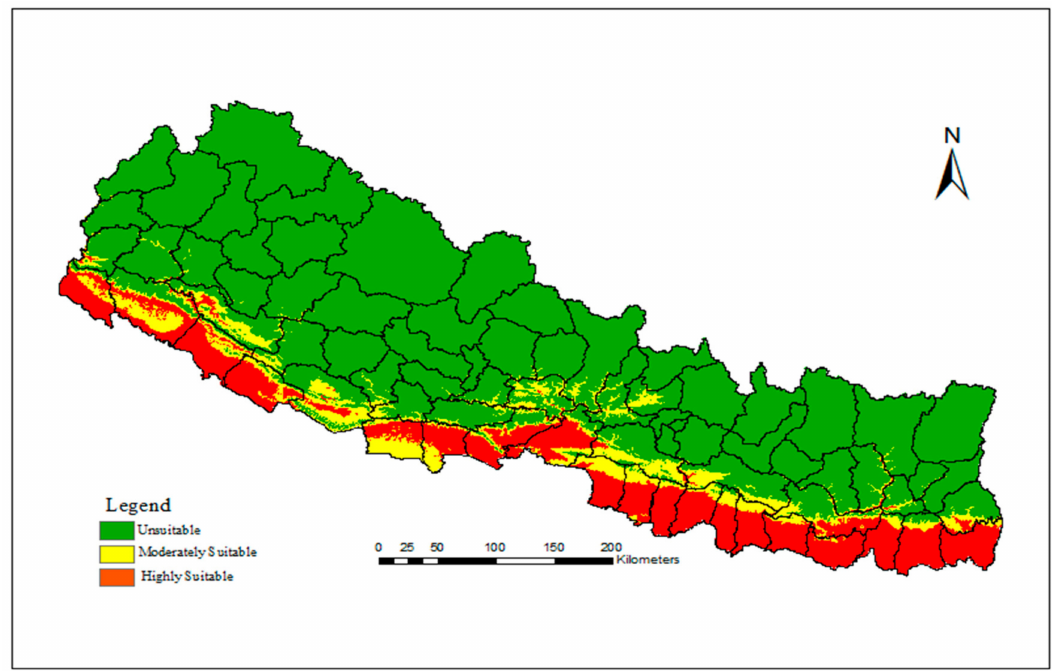
Figure 4. Spatial distribution of present day climatically suitable areas of dengue fever in Nepal obtained from MaxEnt modelling